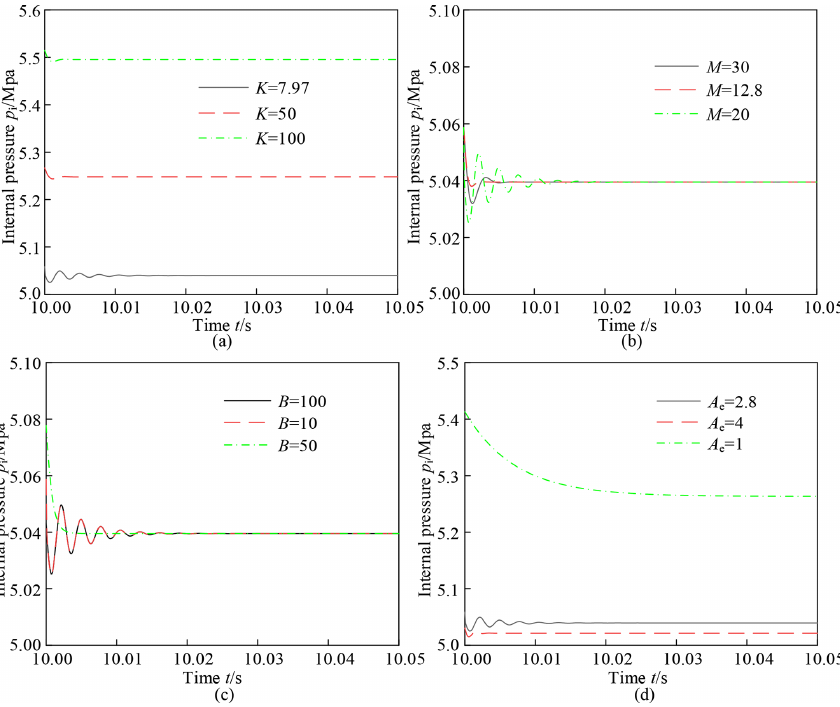
Figure 11. Internal pressure variation within